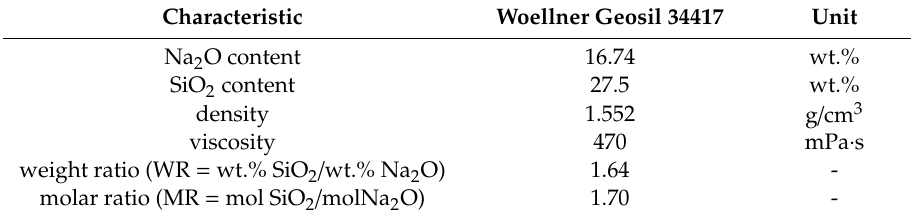
Table 2. Geosil—product characteristics. Based on data provided by the manufacturer.